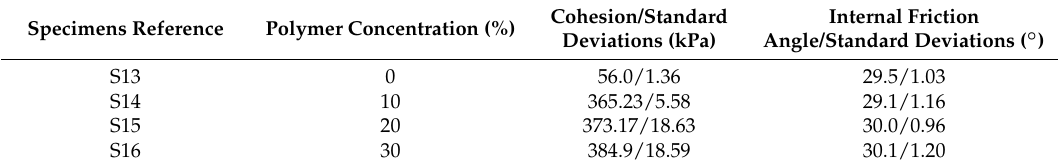
Table 4. Cohesions and internal friction angles of polymer improved